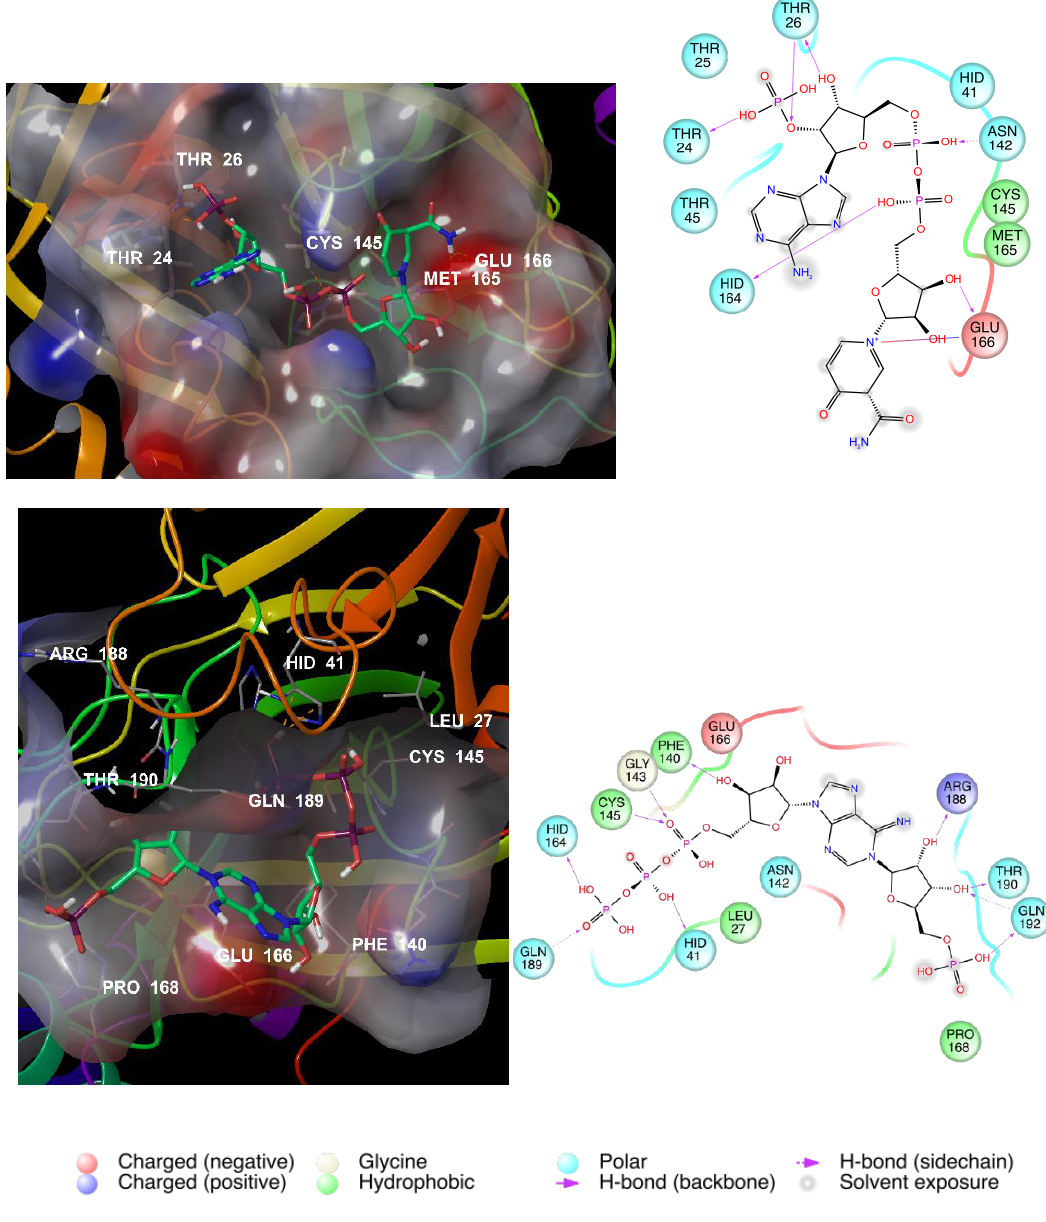
Figure 3. Binding of the best scored compounds (ID 49867432, top image; and ID 16019963, bottom image) into the COVID-19 M PRO active site (left) and amino acid maps (right).